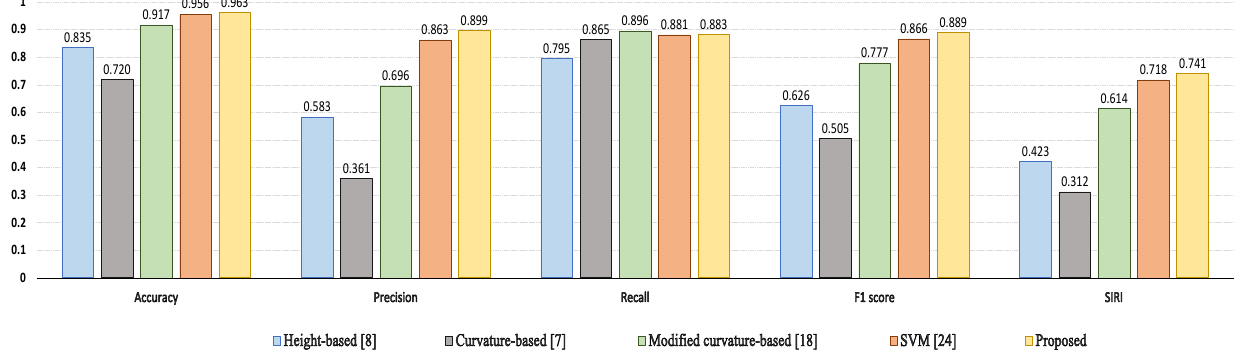
Figure 15. Performance evaluation of the relief extraction methods in terms of precision, accuracy, recall, F1 score, and